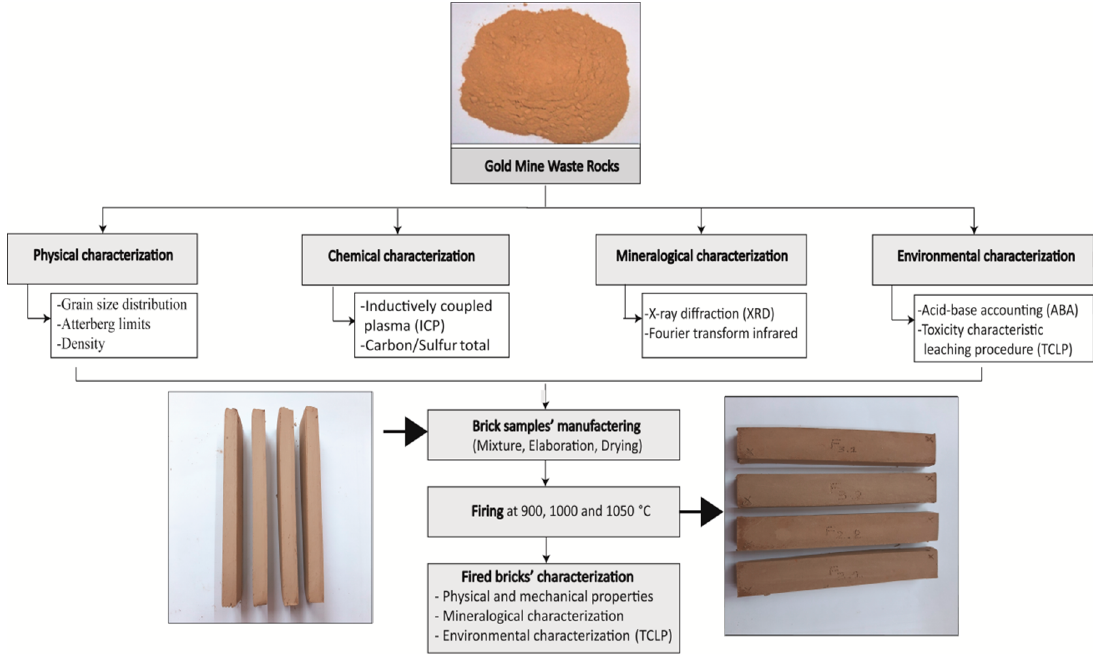
Figure 1. Summary of the followed methodology.